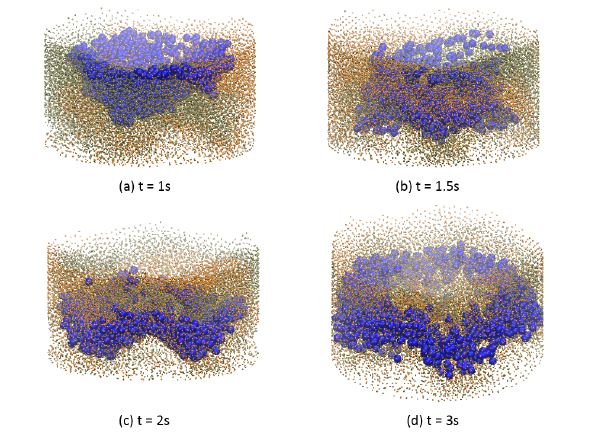
Figure 12. Liquid distribution evolution during mixing